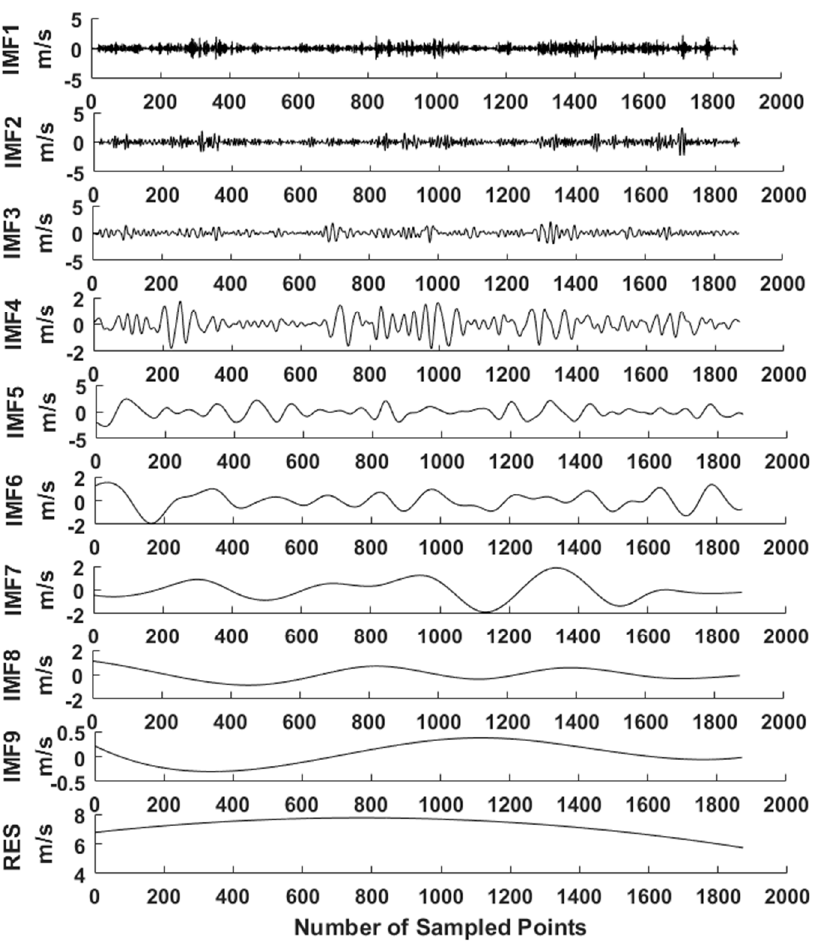
Figure 9. Data from EEMD decomposition.